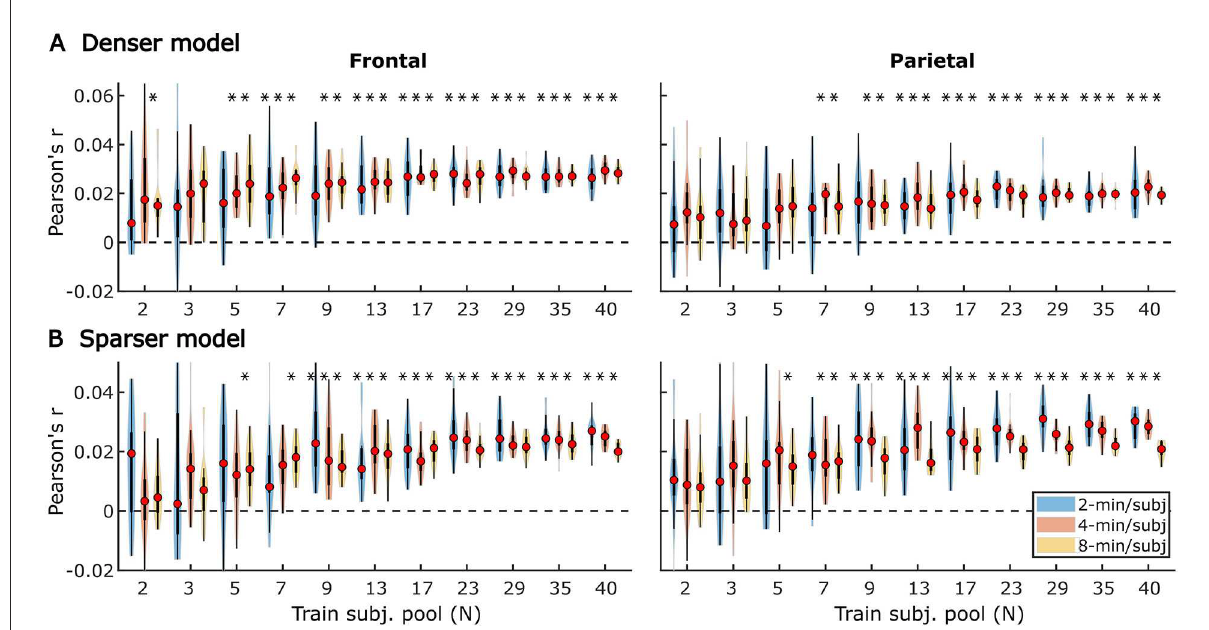
FIGURE9 Noise floor-corrected generic model prediction accuracy distributions as a function of training subject pool size, for denser (A) and sparser (B) models with 2-, 4-, and 8-min of training data per subject (violin color; see legend in the lower right plot). The distributions depicted by violin plots represent collection of mean prediction accuracies across 20 resampling analyses (instead of across-subject variability seen in Figures 1, 2). As such, only subject counts with distributions with no overlap with zero are deemed to be significant at p < 0.05 (uncorrected), as indicated by asterisks above the respective violins. To improve readability, the significance markers are offset slightly to the left of their respective violins. Note that for each triplet of violins, the training subject pool is fixed with a value indicated by the x-tick label below the central violin of the triplet.